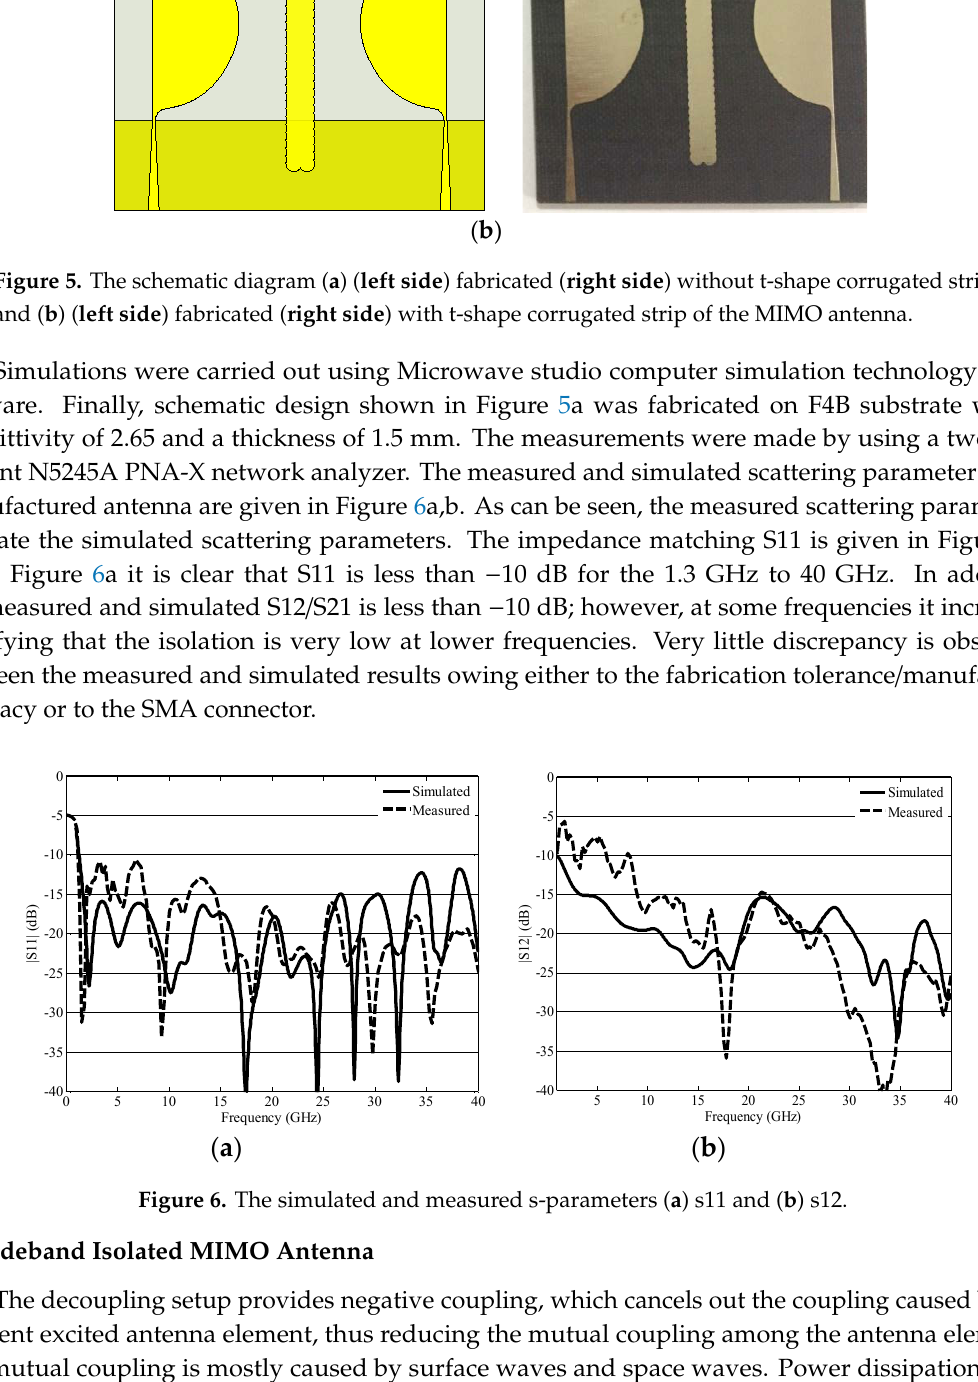
Figure 6. The simulated and measured s-parameters ( a ) s11 and ( b ) s12.